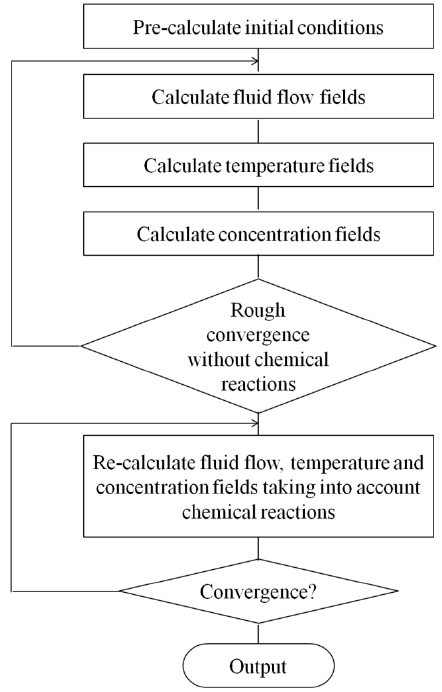
Figure 2. Solution flow chart of the simulation.